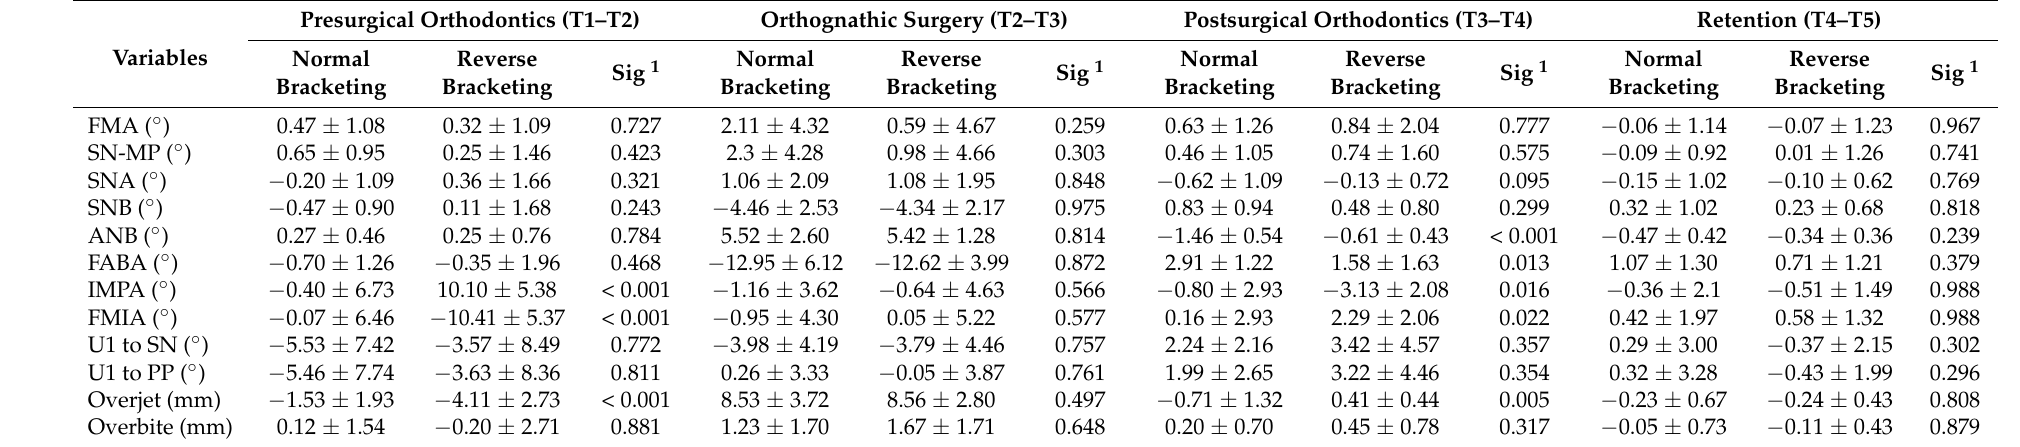
Table 4. Changes in dentoskeletal characteristics of the two groups at each time